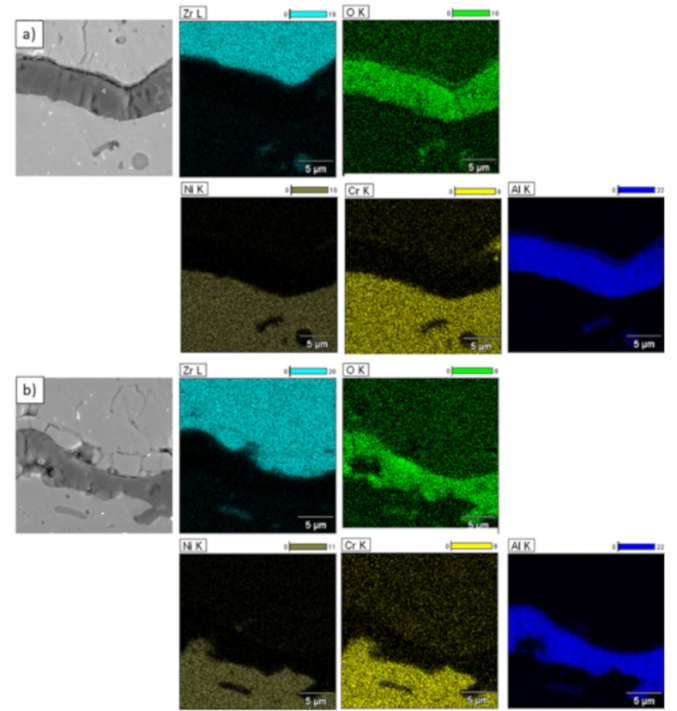
Figure 19. Element distribution in TGO zone after 500h of oxidation at a temperature of 1100 ◦ C—DCL La 2 Zr 2 O 7 / 50% La 2 Zr 2 O 7 + 50% 8YSZ / 8YSZ TBC (SEM): ( a ) zone of the bond-coat bottom and ( b ) zone of the bond-coat